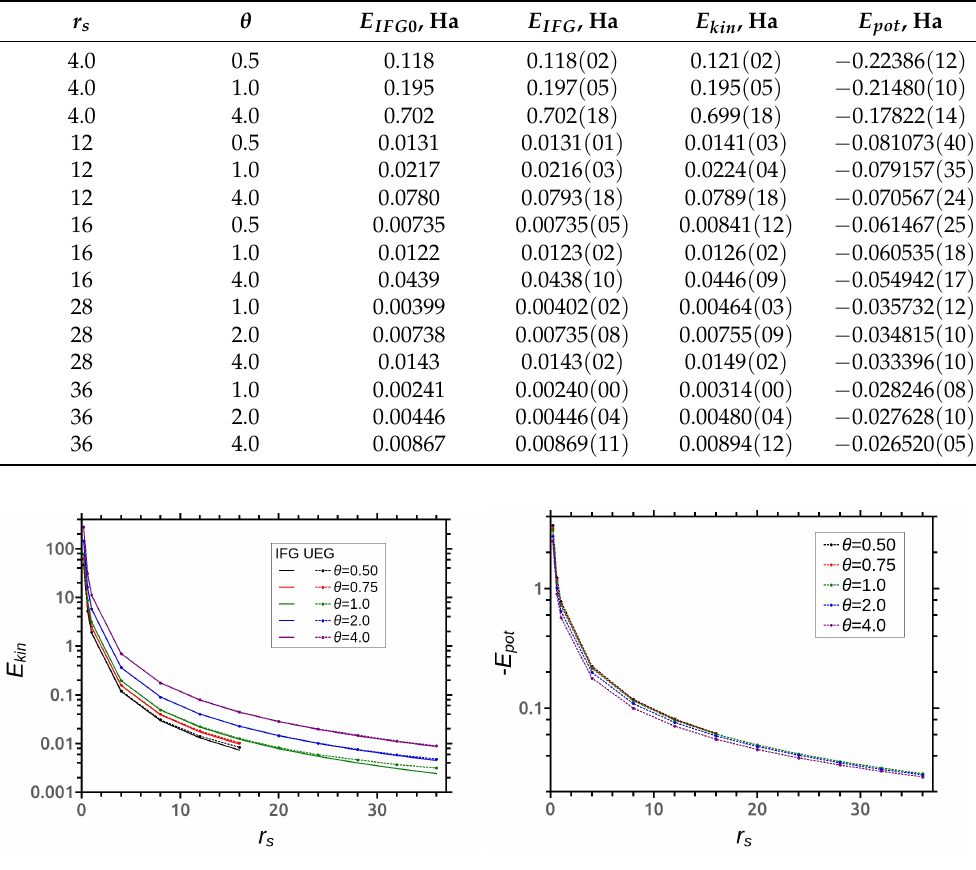
Figure 6. Left plot: average kinetic energy of the UEG at different values of r s and θ compared with the internal (kinetic) energy of the IFG. Right plot: average potential energy of the